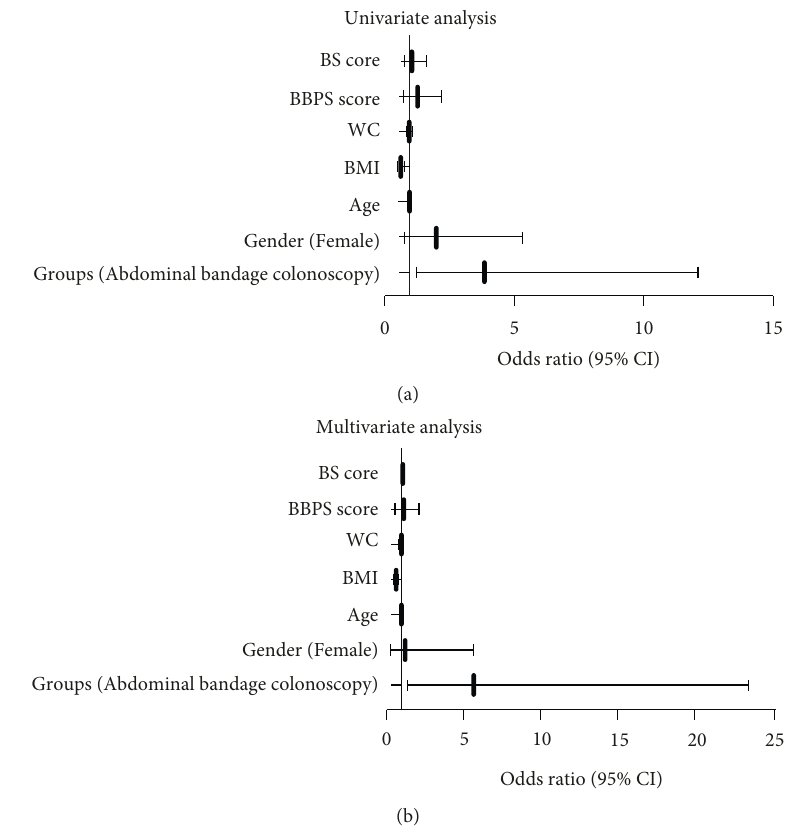
Figure 3: Logistic regression analysis of associated factors with CCR. (a, b) Univariate and multivariate regression analyses showed BMI was a risk factor for lower CCR, whereas the use of abdominal bandages was associated with higher